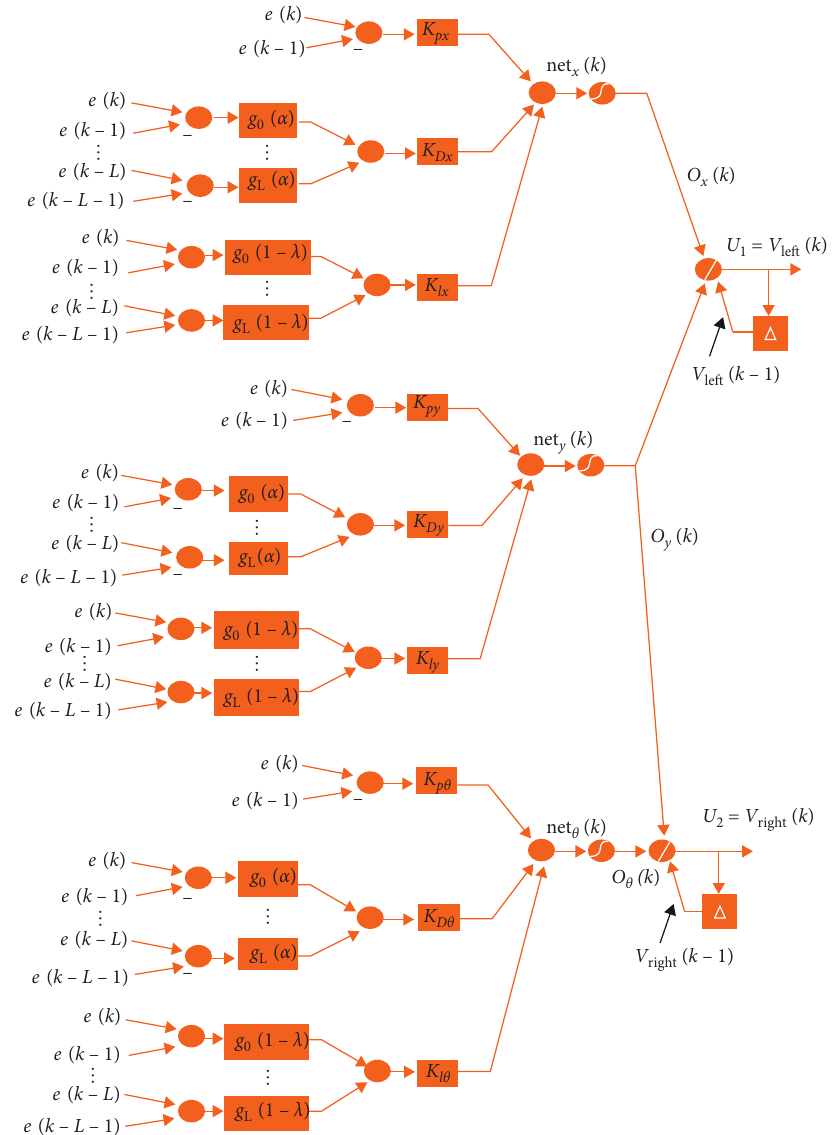
Figure 3: The proposed structure of the NNFOPID controller for